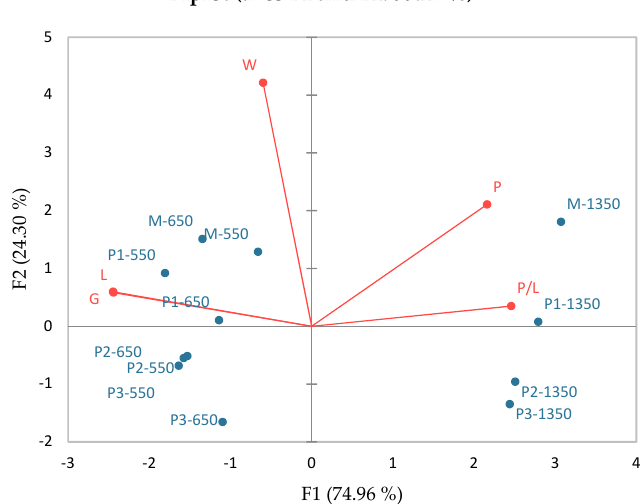
Figure 5. Principal component analysis (PCA) graph showing the distribution of rheological variables for the dough samples analyzed.